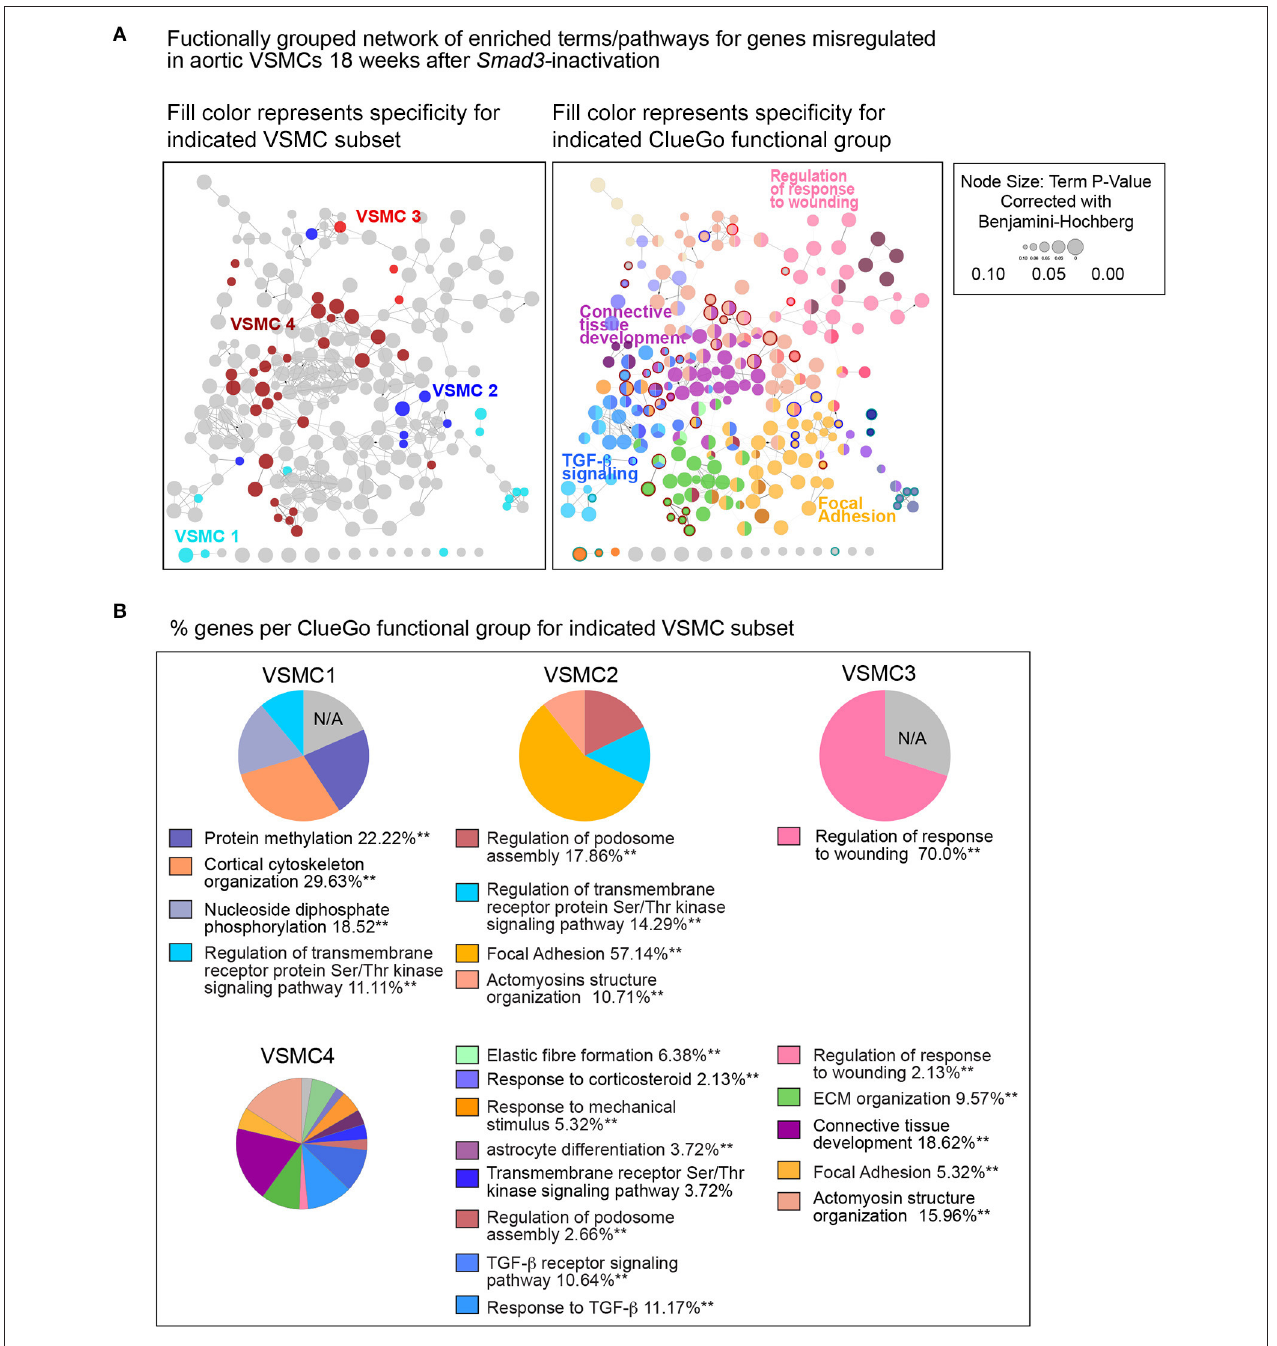
FIGURE 8 | Functional network of global and subset-specific enriched terms for genes dysregulated in response to Smad3 -deficiency in VSMCs. (A) The top 200 dysregulated transcripts for each subset (regardless of direction) were analyzed using the multiple-clusters option in ClueGO, which allows for the simultaneous analysis and visualization of both cluster-specific and non-cluster specific enriched pathways and biological terms in a functional network. In the left panel, enriched nodes are colored based on specificity for a given VSMC subset, while non-specific terms are left grey; on the right panel, network nodes fill color corresponds to the ClueGO functional group to which they belong, with terms belonging to more than one group filled-in by more than one color. Terms and pathways significantly enriched in only one VSMC cluster are identified by the color of the node’s border. (B) The distribution of genes per ClueGO functional group for each VSMC